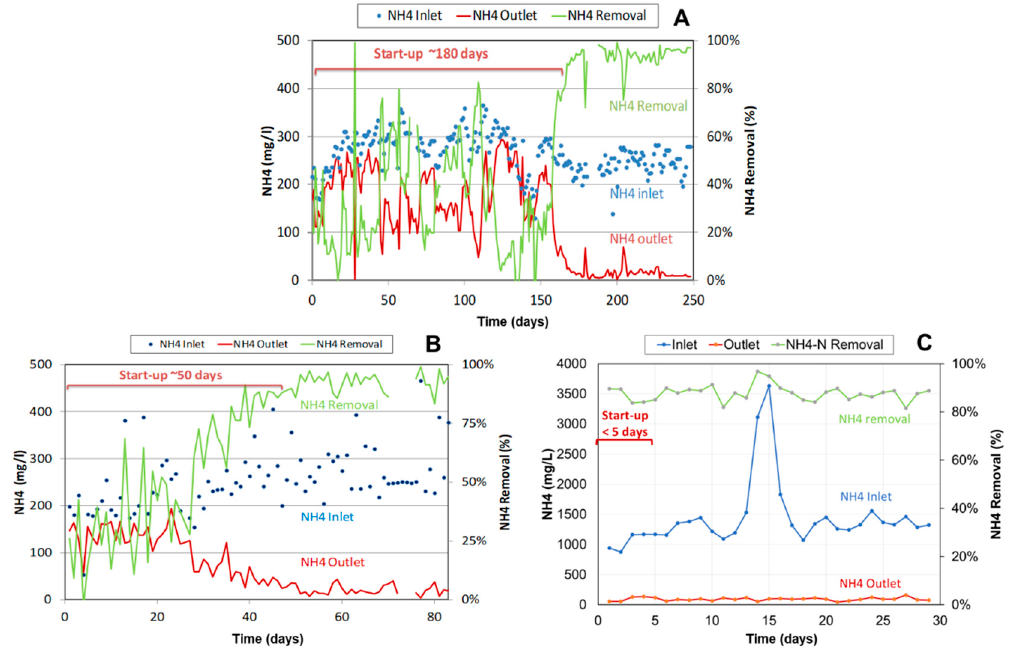
Figure 6. Start-up time for 3 PN/A ANAMMOX reactors: Case ( A ): (600 m 3 ) in 2006 taking 180 days; Case ( B ): (1230 m 3 ) in 2012 taking 50 days; and Case ( C ): (425 m 3 ) in 2019 taking less than 5 days.